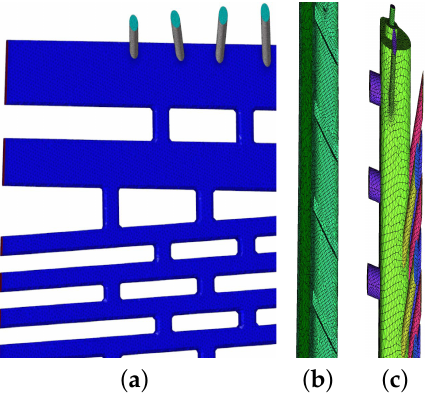
Figure 2. Local computational elements for CHT analysis: ( a ) pin-fin in the trailing-edge region; ( b ) rib-turbulated serpentine channel; ( c ) film-cooling holes in the leading-edge